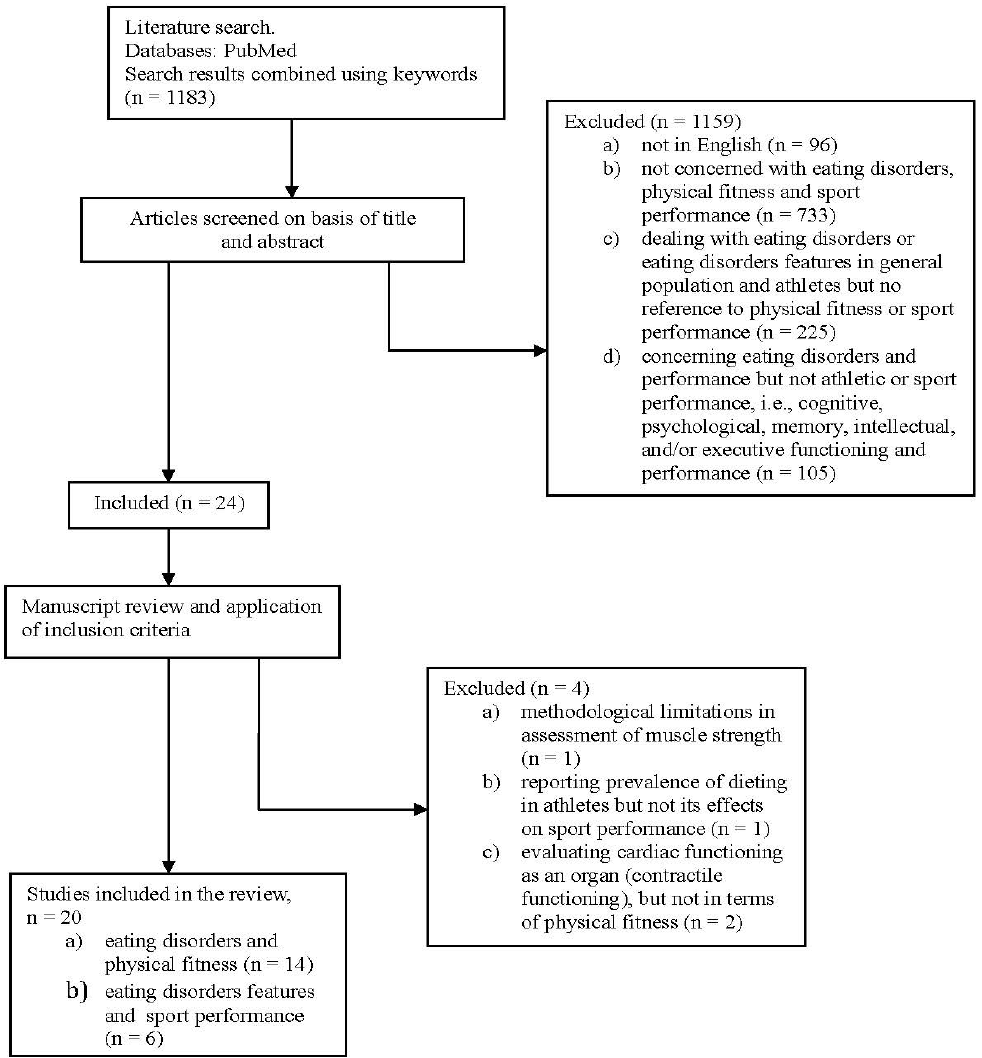
Figure 1. Flow chart summarizing the study selection procedure; An additional 9 studies included in the review were found in books and non-electronic